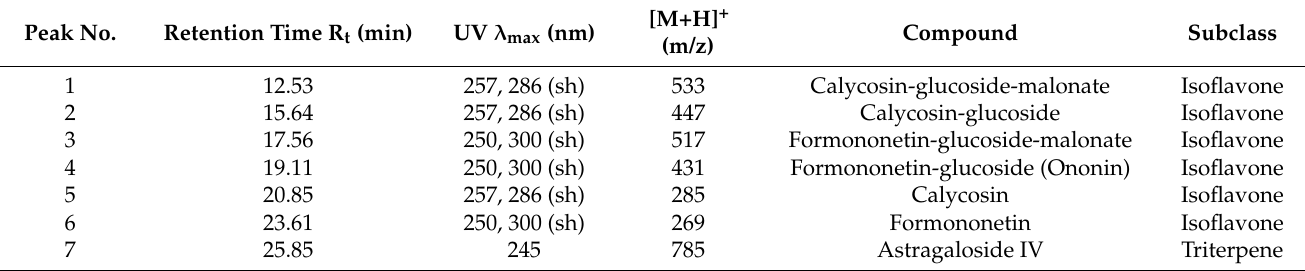
Table 3. Retention time (Rt), [M+H] + and other MS ions, UV λ max of the isoflavones identified from the ASTRA root extracts.